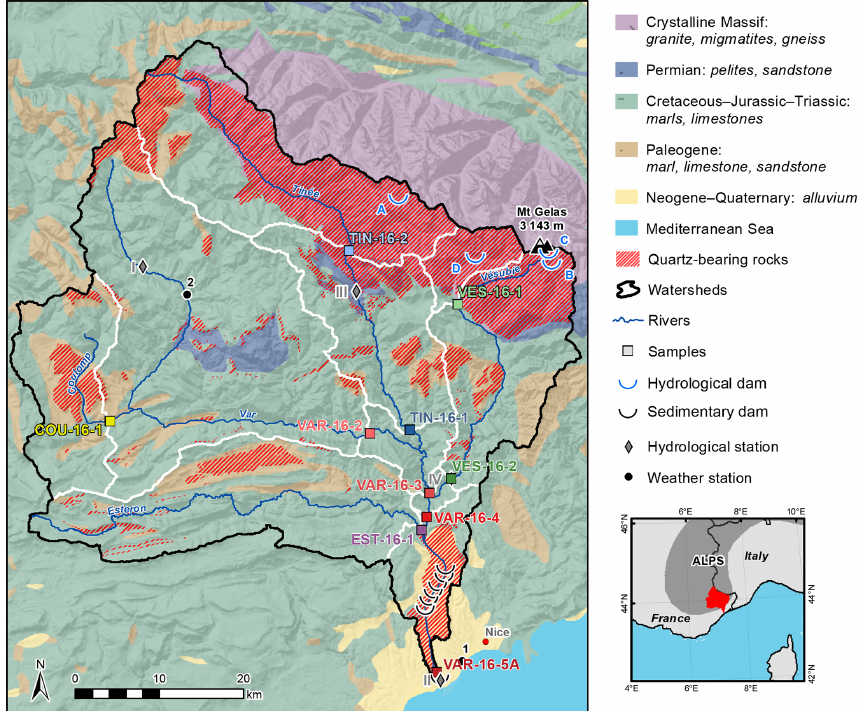
Figure 1. Geological setting of the Var basin and its subbasins. Geological data are from the French Geological Survey (see text for ref- erences). White lines delimit the sampled subbasins, colored squares represent sampling points, and red hashed areas indicate the presence of quartz-bearing rocks. Hydrological station data are from the HYDRO database (http://www.hydro.eaufrance.fr/, last access: 6 Decem- ber 2019): (I) Villneuve d’Entraunes station; (II) Nice, Pont Napoléon station; (III) Saint-Sauveur-sur-Tinée station; and (IV) Utelle station. Hydrological dams are (A) Isloa 2000 dam, (B) Lac Fous dam, (C) Lac Long dam, and (D) Lac Boréon dam. Weather stations are from Météo France: (1) Nice and (2) Guillaumes. The regional map indicates the location of the Var basin in the southern French